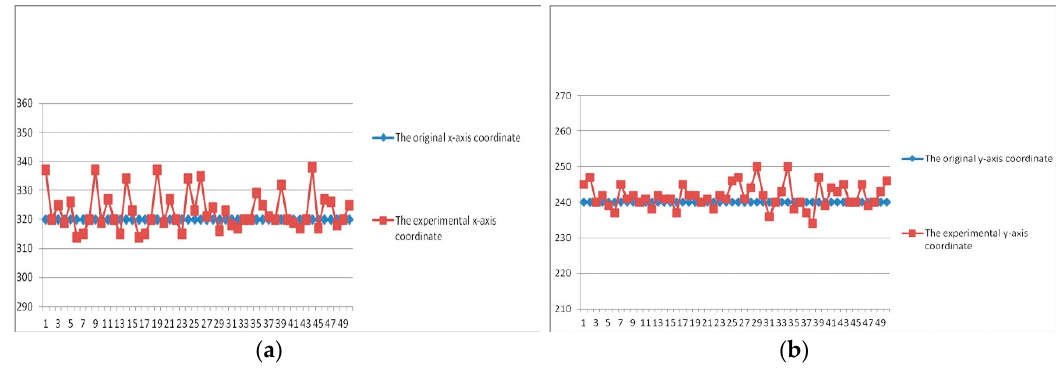
Figure 8. The test results of computing position stability of this study; ( a ) x axis coordinate; ( b ) y axis coordinate.